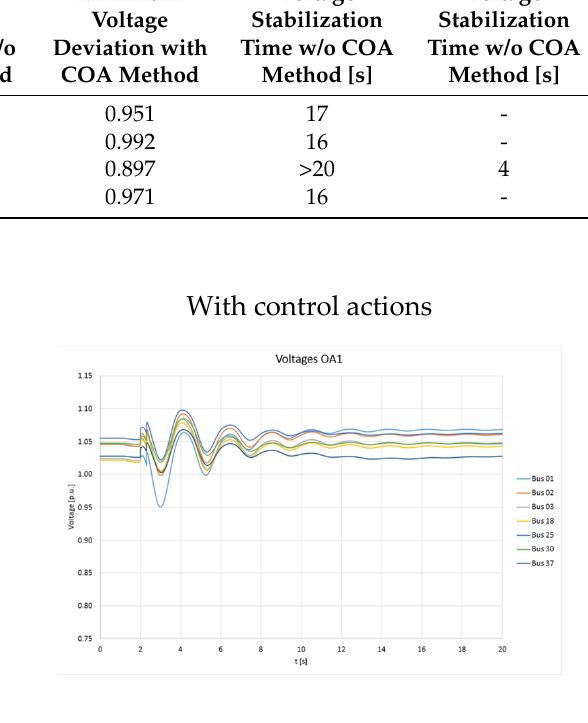
Table 3. Voltage deviation comparison for the classical literature method and proposed COA method. Outages of transmission lines 5–8 and 6–7.